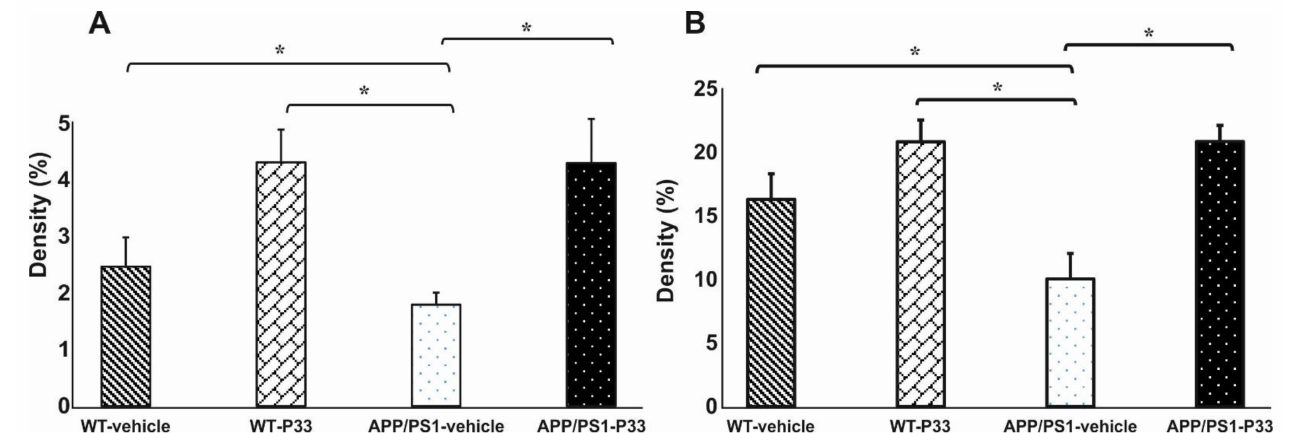
Figure 4. Quantitative results for BrdU and DCX stainings in DG of the animals. ( A ) Significant differences were observed among the groups in the densities of dividing cells ( p = 0.026). Decreased BrdU+ cell density was detected in the vehicle-treated APP/PS1 group compared to the WT-vehicle ( p = 0.030), the WT-P33 ( p = 0.008) and the APP/PS1-P33 groups (p = 0.009). ( B ) Results for DCX immunostaining. A significantly lower level of immature neuron density ( p < 0.001) was detected in vehicle-treated APP/PS1 mice compared to all other groups (vs. WT-vehicle: p = 0.028, vs. WT-P33: p < 0.001, vs. APP/PS1-P33: p < 0.001). Data represent mean ± SEM * indicates a significant difference ( p <